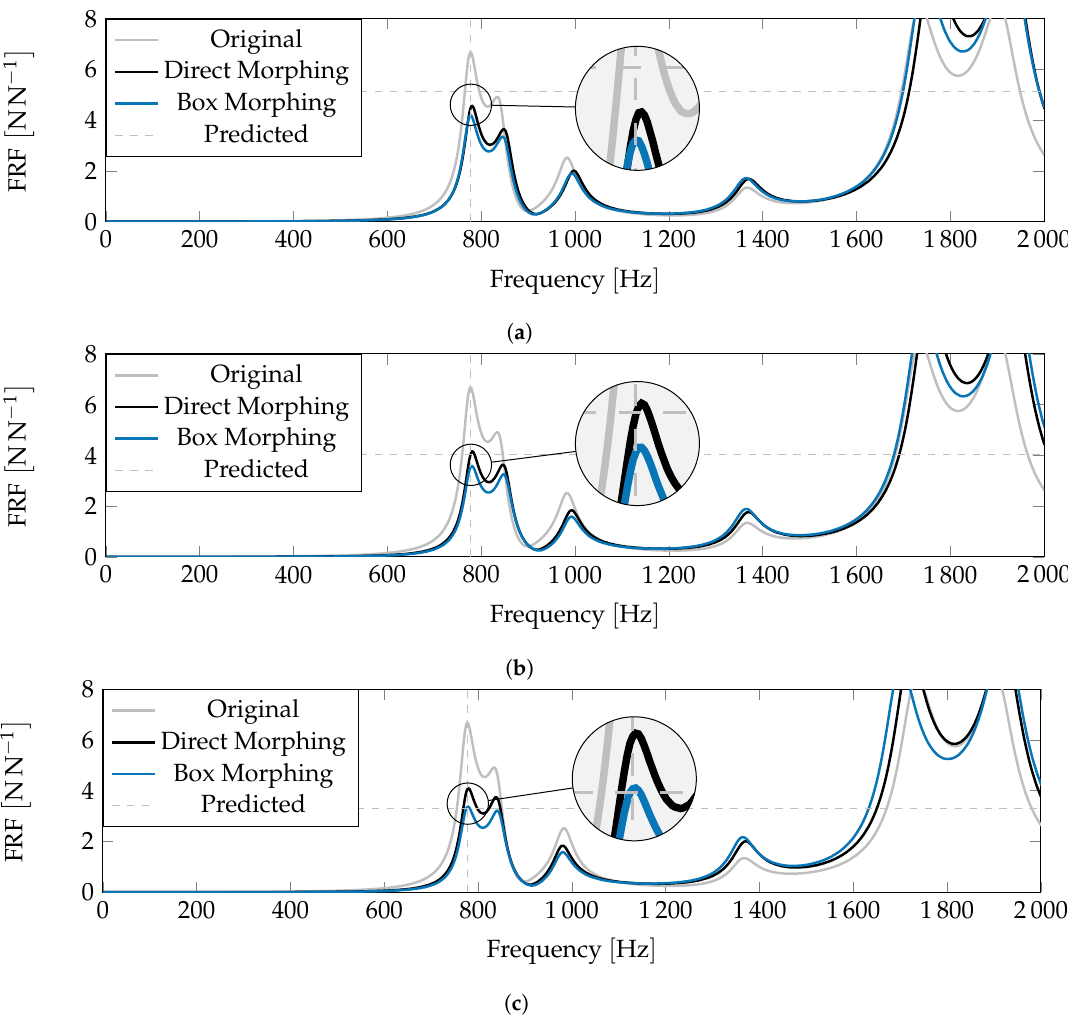
Figure 11. Three different optimization methods and simulation results obtained by different morphing approaches. ( a ) Manual Optimization via separate metamodels in Figure 10. ( b ) Optimization via Optislang metamodel resulting from Direct Morphing data. ( c ) Optimization via Optislang metamodel resulting from Box Morphing